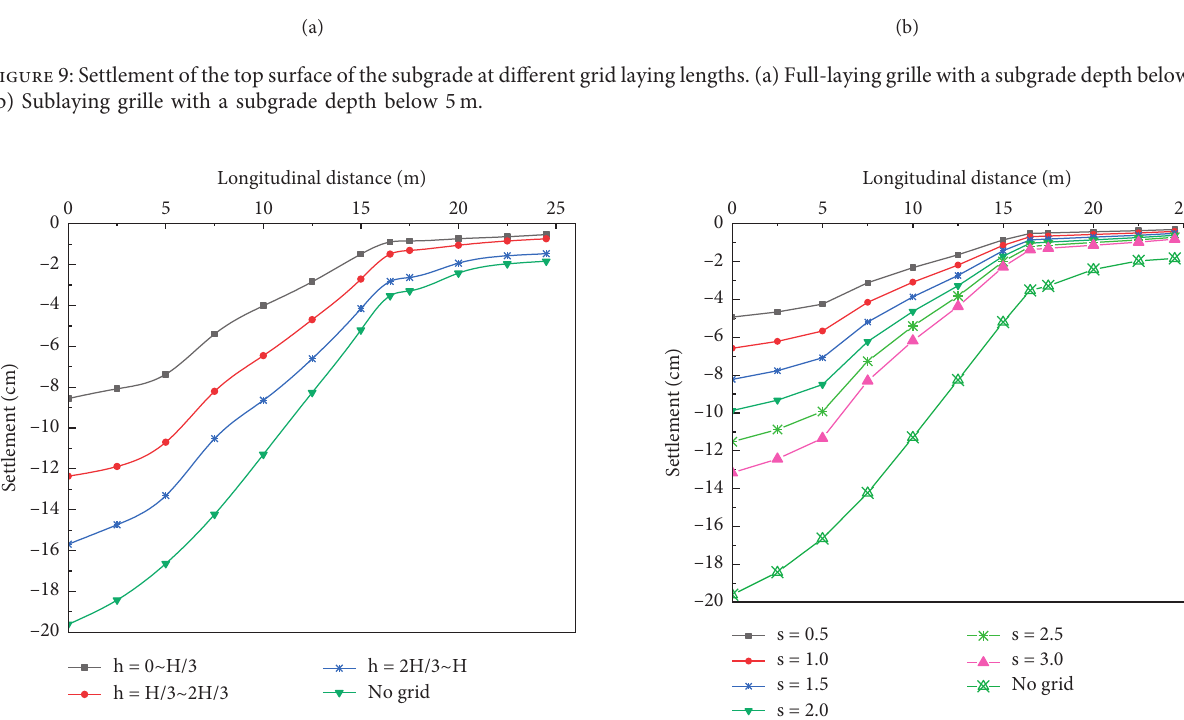
Figure 11: Settlement of the top surface of the subgrade at different grid laying